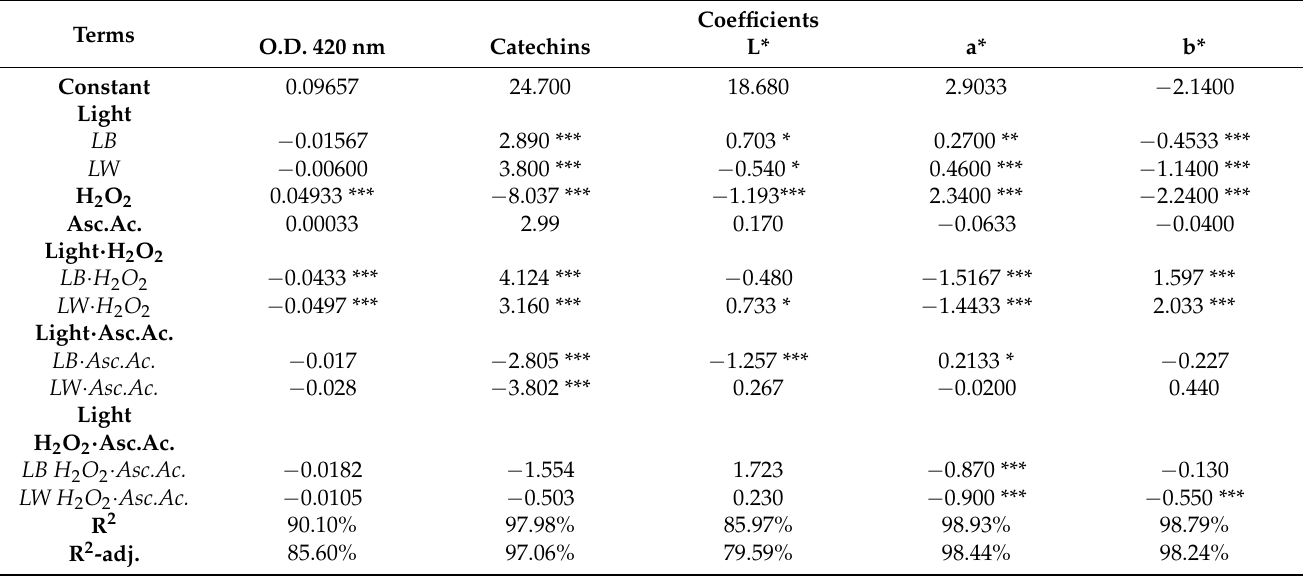
Table 2. Regression coefficients of the ANOVA of third-order polynomial model for OD 420 nm, catechins, L*, a* and b* parameters after light exposure (LB and LW), hydrogen peroxide, and ascorbic acid